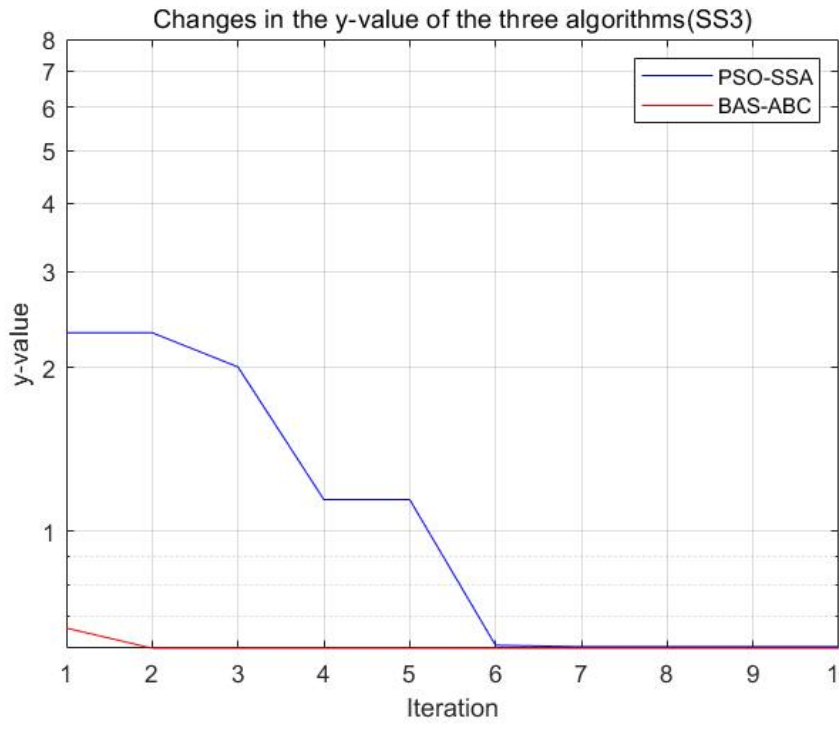
Figure 23. Changes in the 𝑦 value of the two algorithms (SYS1).